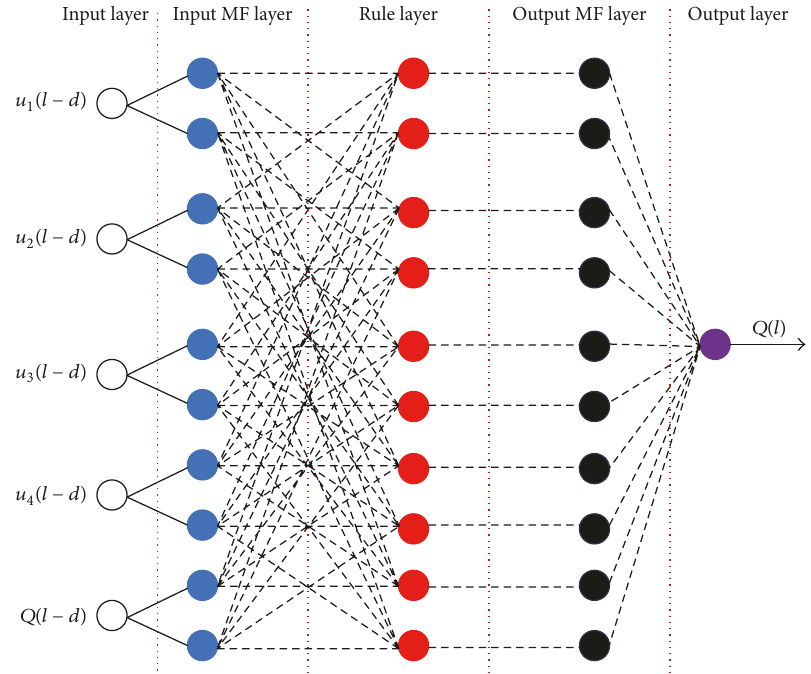
Figure 2: MISO-DANFIS model diagram